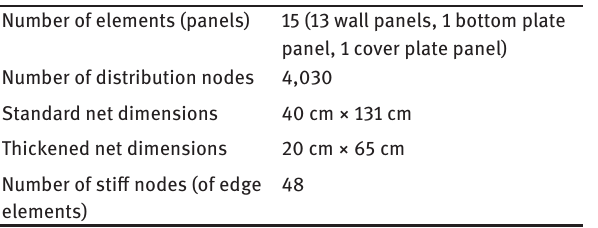
Table 3: Data on discretisation of the silo model (finite element method).